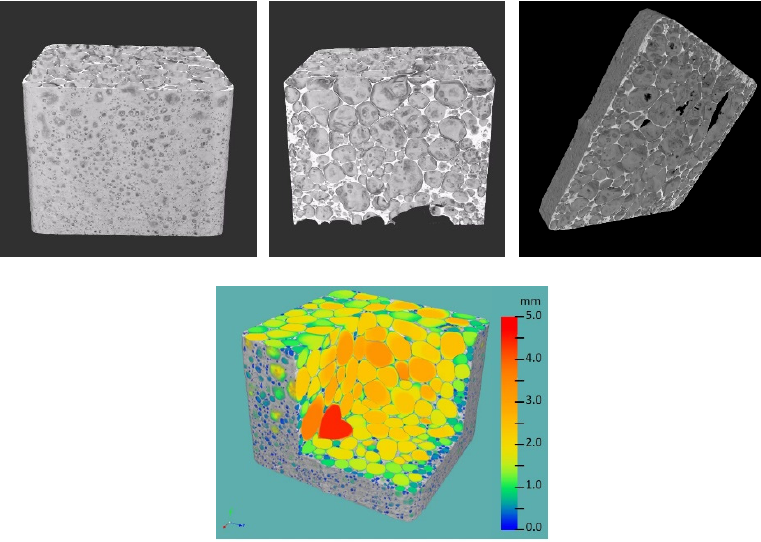
Figure 4. Volume rendering showing the cellular structure and the dense metal skin covered a closed-cell foam (width: 20 mm) with color by local structure separation, a measure of pore size.